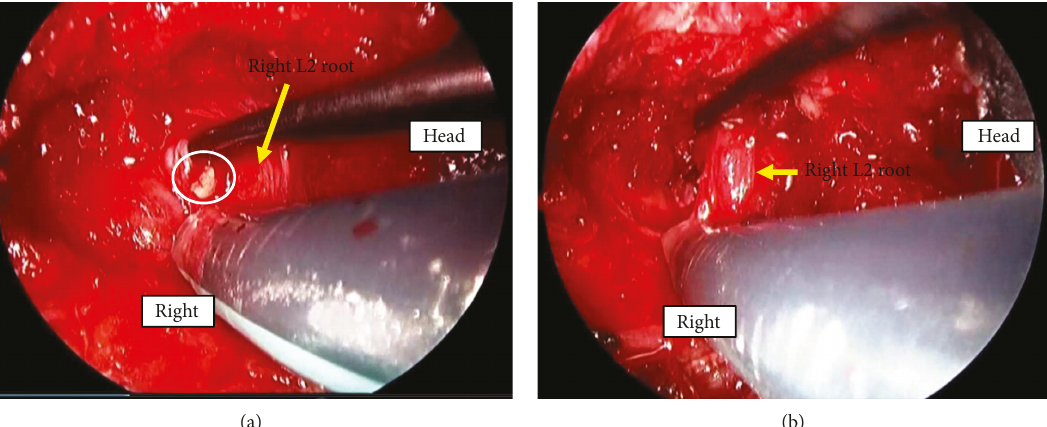
Figure 3: (a) There was the fragment covered in a fi brous fi lm of the posterior wall of fractured vertebral body compressing L2 root from the front at foramen. (b) After removing the fragment, the root was